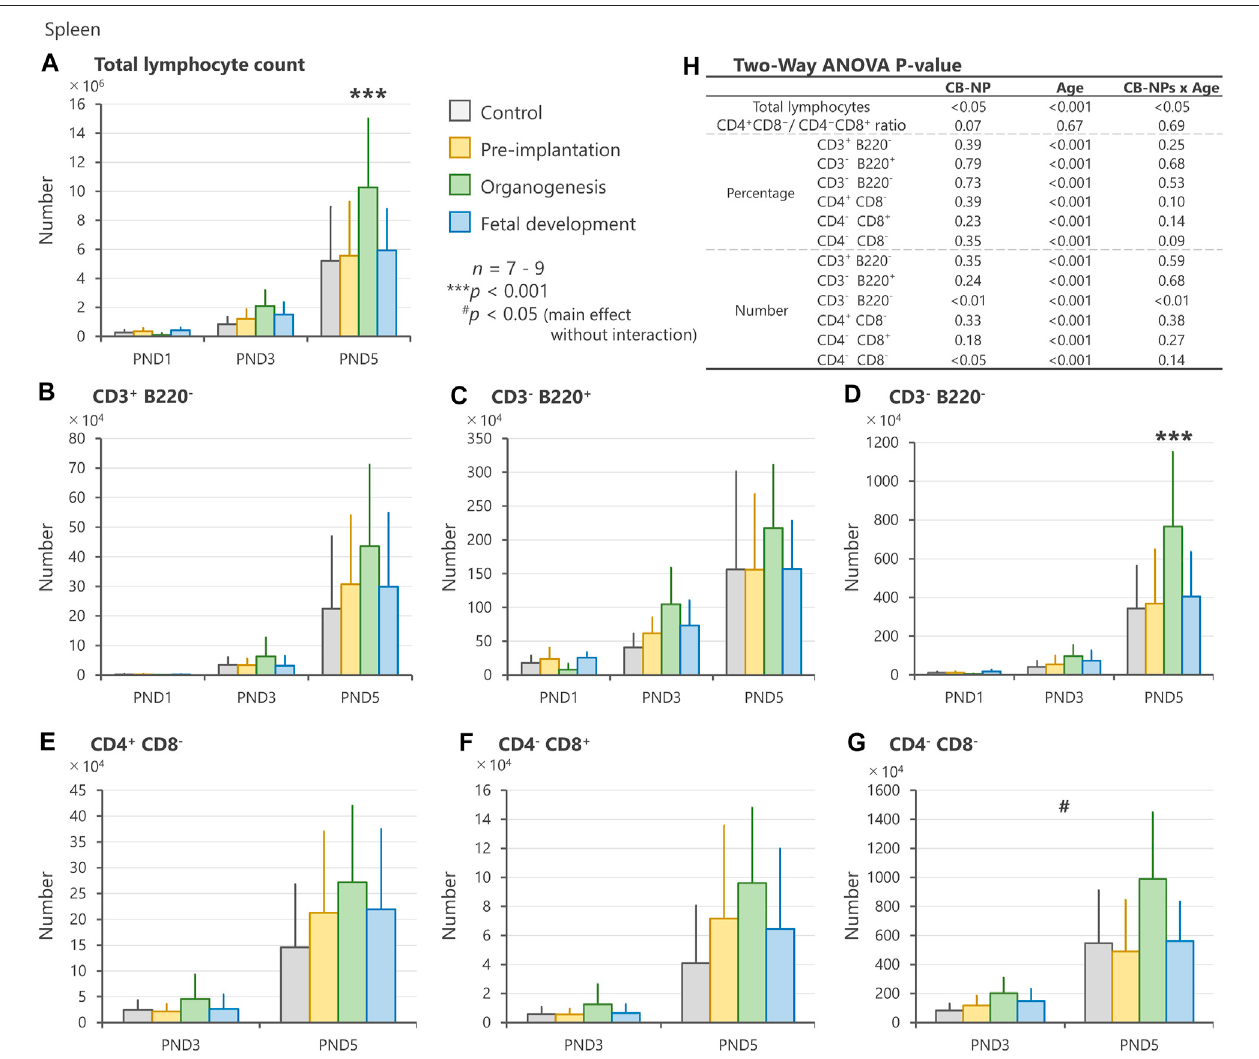
FIGURE 5 | Effect of maternal exposure to carbon black nanoparticle (CB-NP) on the number and percentage of each lymphocyte in the spleen of offspring at postnatal day 1, 3 and 5, as measured by fl ow cytometry. (A) : Number of total lymphocytes in the spleen. (B – G) : Number of each lymphocyte calculated based on the totallymphocytesandpercentageofeachcelltype. (H) :All p-values calculatedbytwo-wayANOVA.Two-wayANOVAshowedsigni fi canteffectsofCB-NPexposureon the number of (A,H) totallymphocytes[F(3, 79) (cid:2) 3.66;* p (cid:2) 0.016]withexposure/age interaction[F(6, 79) (cid:2) 2.53; * p (cid:2) 0.027]; (D,H) CD3 − B220 − [F(3, 79) (cid:2)